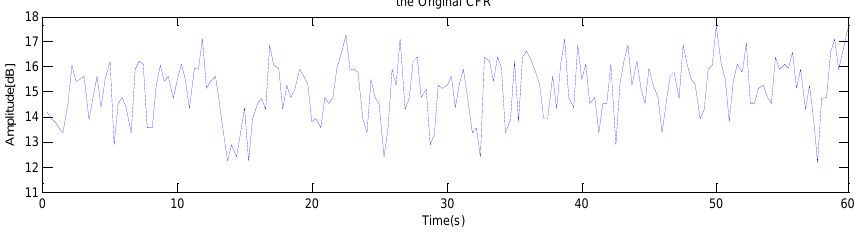
Figure 19. Raw WCI for abnormal breathing using C-Band.